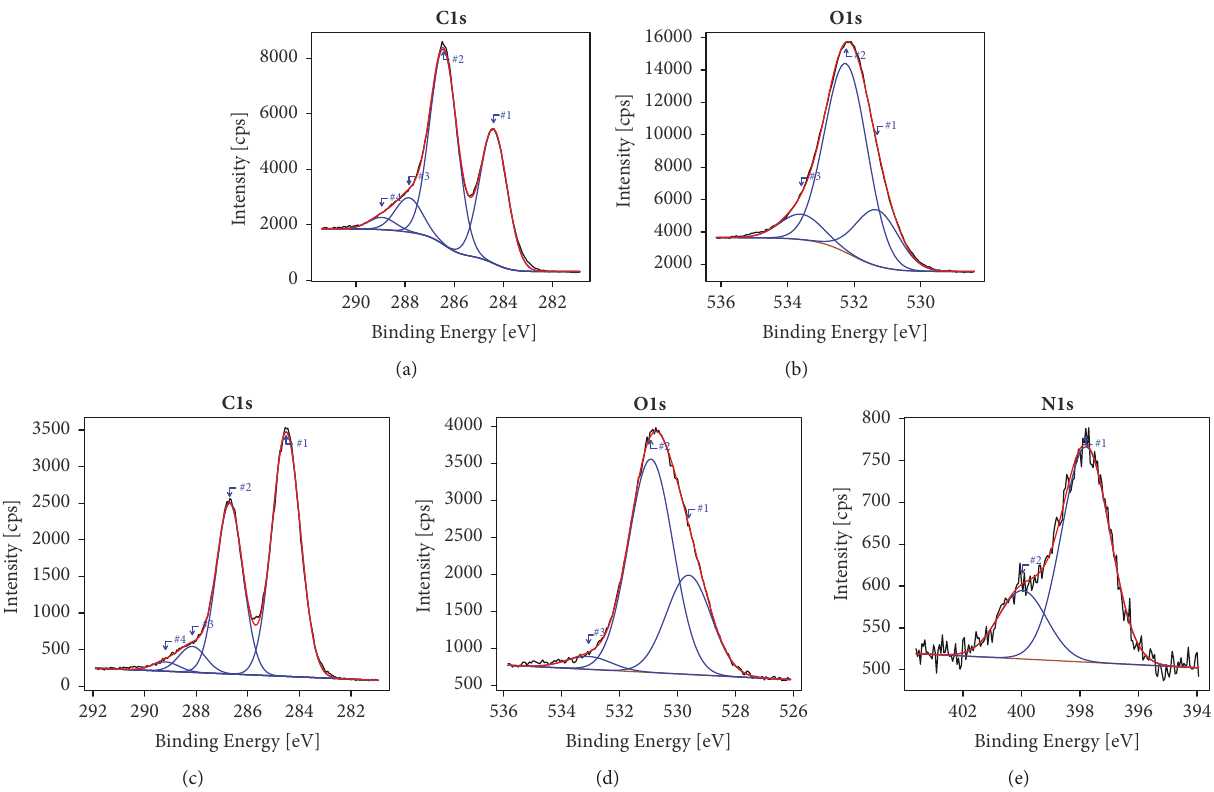
Figure 1: Chemical components on the nanoparticles surface. (a) Carbon core line and (b) oxygen core line in GO; (c) carbon core line, (d) oxygen core line, and (e) nitrogen in GO-NH 2 .